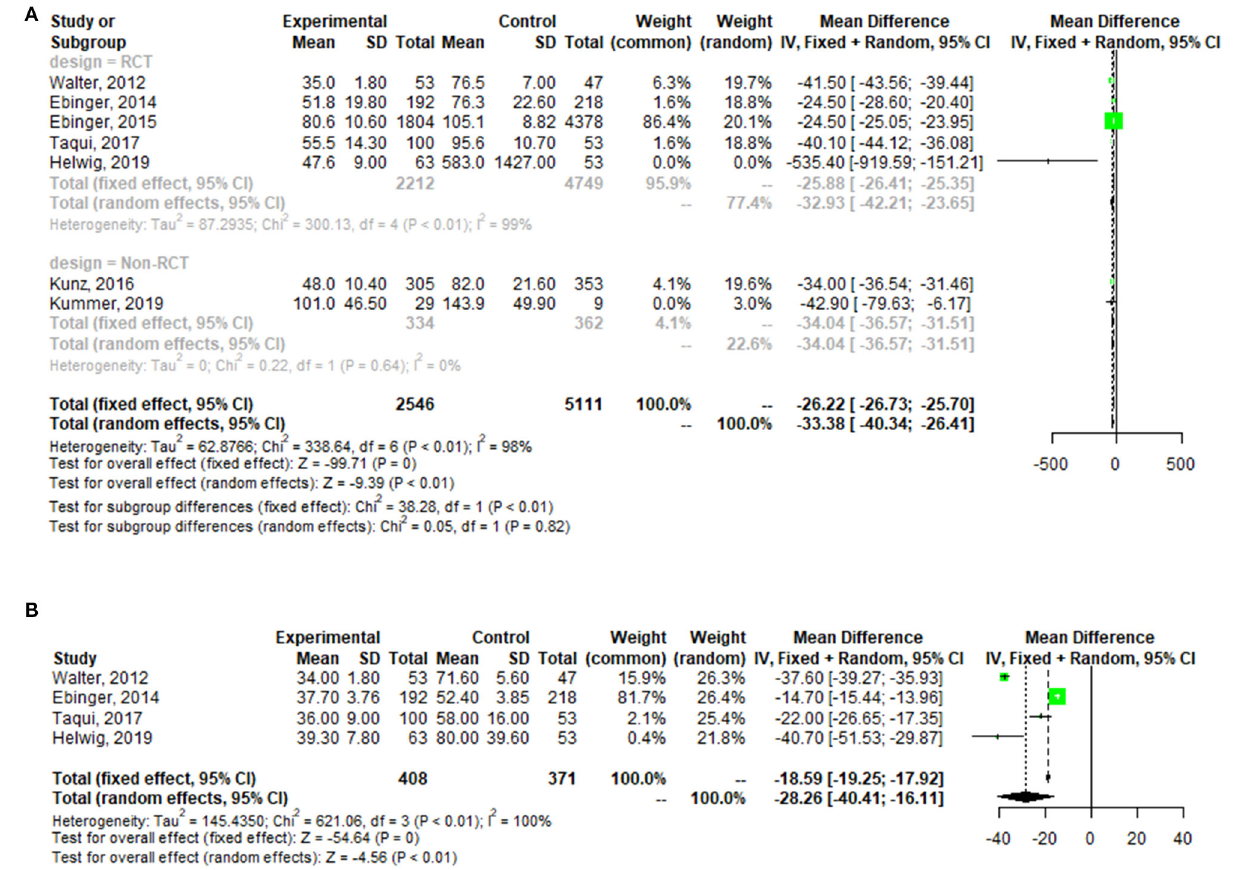
FIGURE A1 | Forest plot for change in the time from alarm to therapy decision [adding Helwig (19)] (A) , and the time from alarm to CT completion (B) .